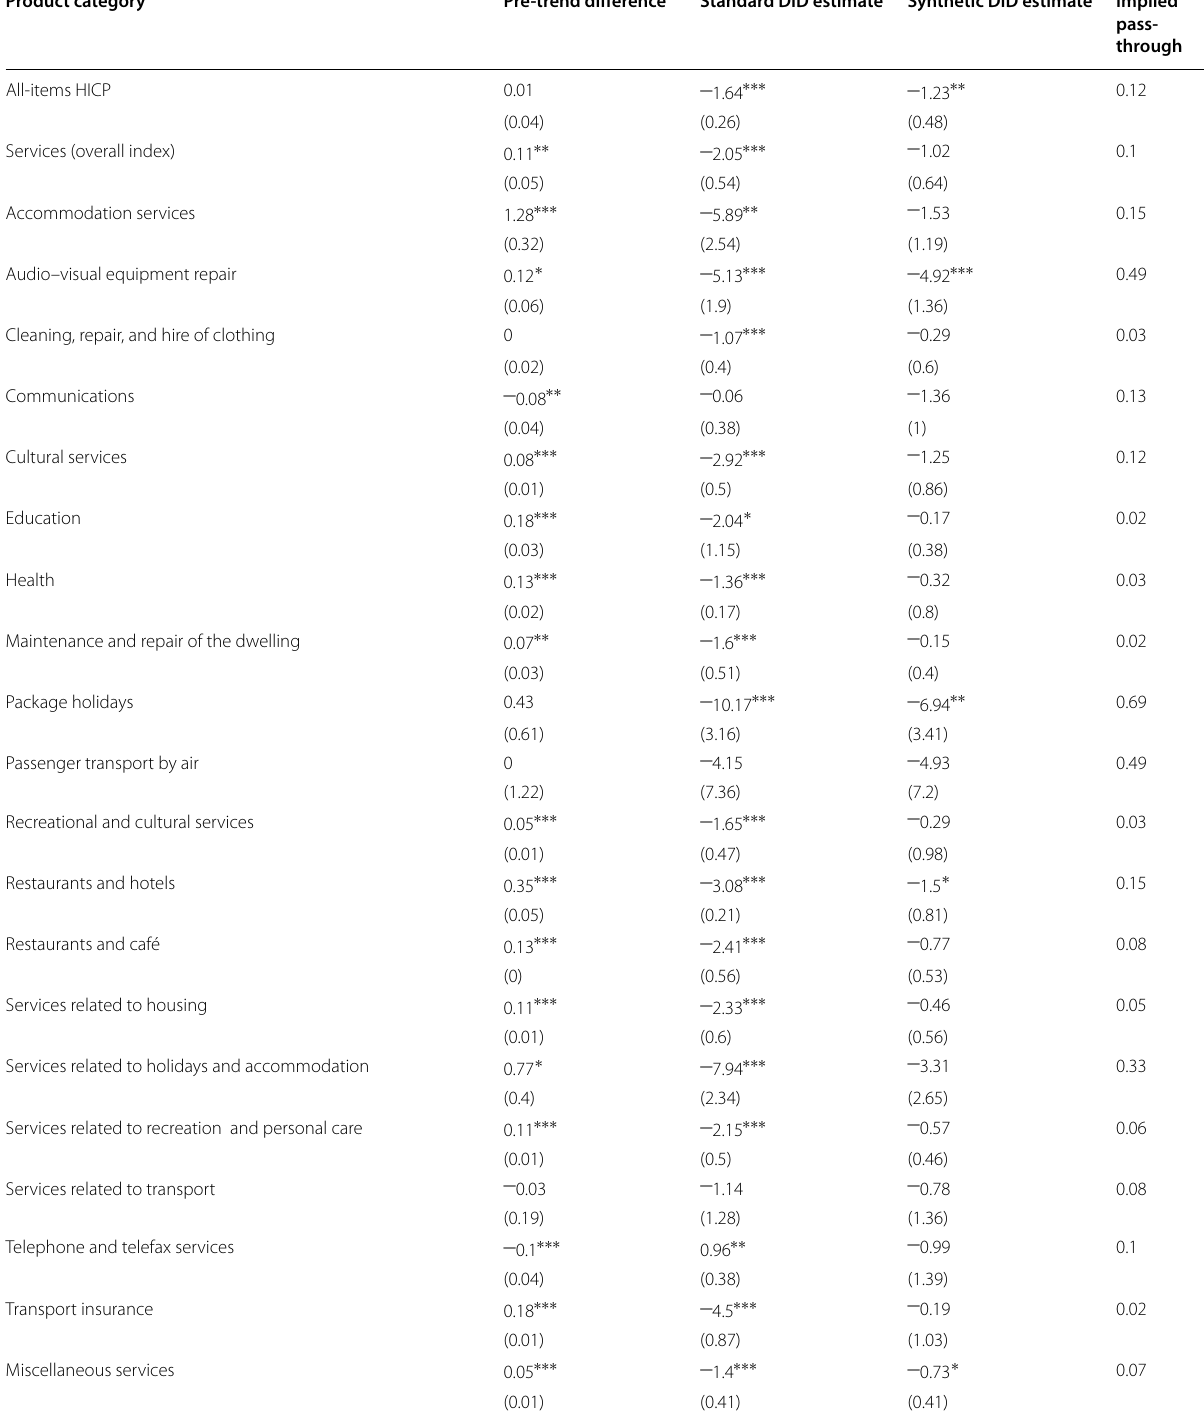
Table 7 Estimates of the exchange rate pass-through to consumer prices for